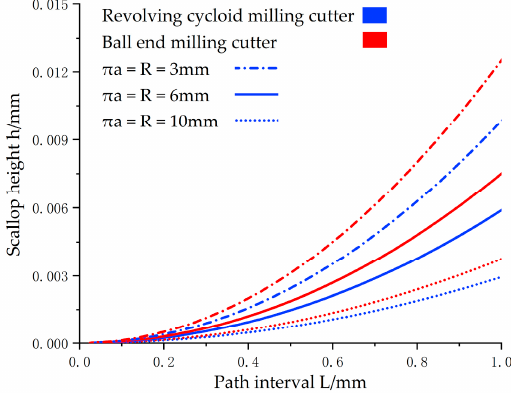
ff erent path Figure 6. Scallop height under different path intervals. Figure 6. Scallop height under different path intervals. Figure 6. Scallop height under di